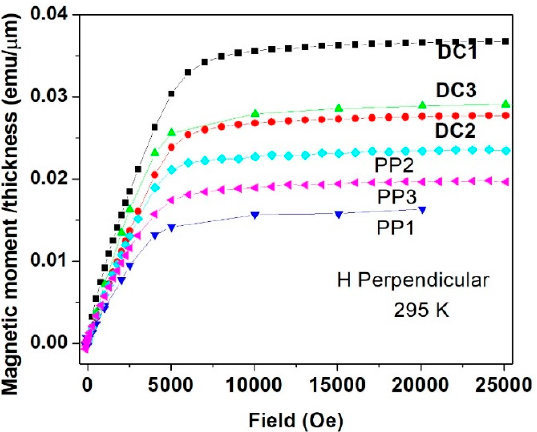
Figure 12. Parallel field dependence of the magnetic moment curves measured at 5 K for all DC and PP deposited quaternary Sn-Fe-Ni-Co alloy coatings.